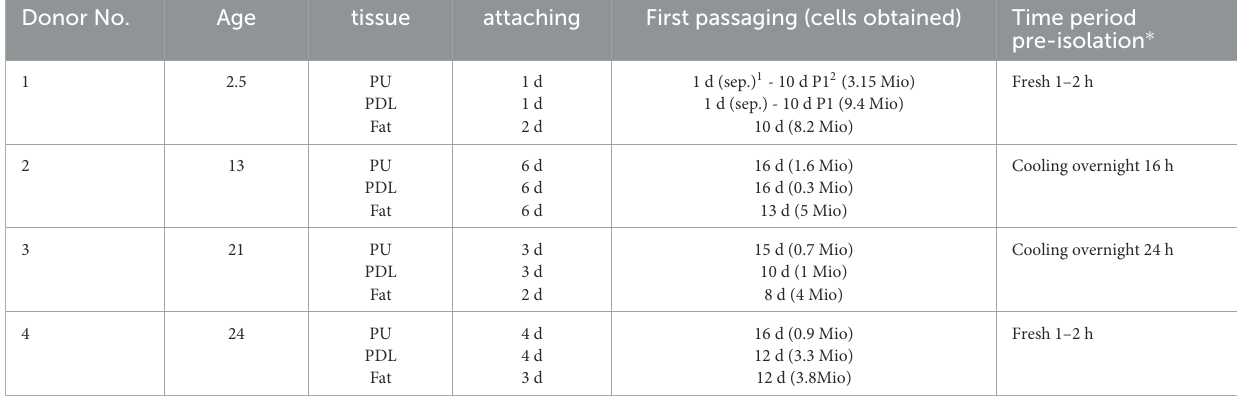
TABLE 5 Time periods MSCs needed to attach and get confluent, when seeding the remaining tissue inside the cell strainer. Donor No. Age tissue attaching First passaging (cells obtained) Time period